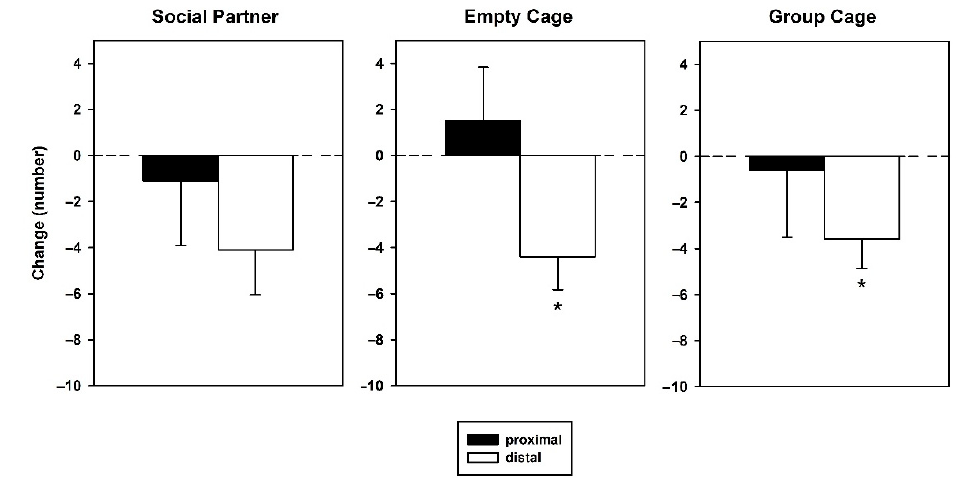
Figure 7. Arm entries in the retest expressed as change scores in arms proximal to (black bars) or distal from the sound source (white bars) in animals, which had access to a conspecific (Social Partner), no social contact (Empty Cage) or their cage mates (Group Cage) immediately after playback in the initial test. Change scores were calculated for arm entries proximal (black bars) or distal from the sound source (white bars) by subtracting entries during the 5 min before stimulus presentation from those during the 5 min of stimulus presentation. Data are presented as means ± SEM. * p < 0.05, compared to baseline.